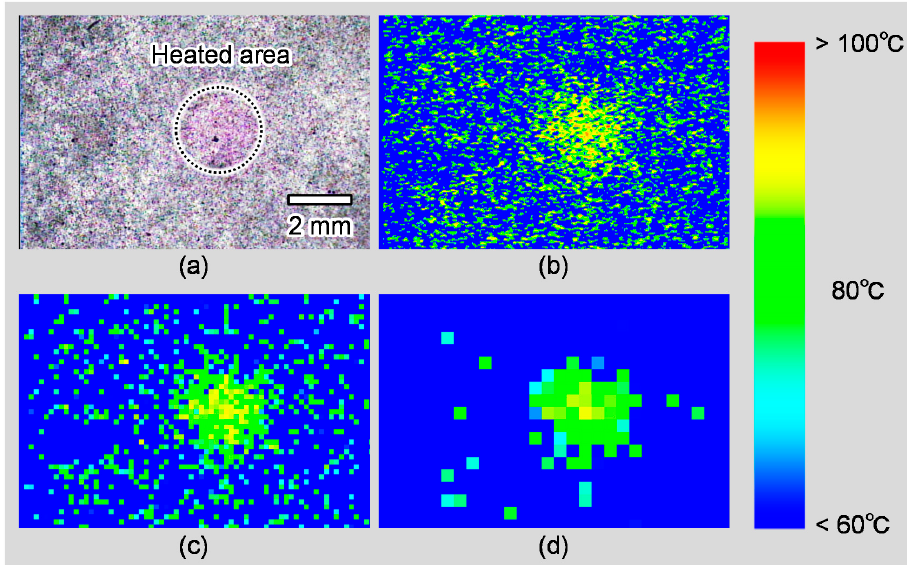
Figure 8. Evaluation of local heated temperature with different averaged areas. ( a ) Original picture of the sheet sample; ( b ) Analyzed image without averaging; ( c ) Analyzed image averaged with 10 × 10 pixels; ( d ) Analyzed image averaged with 25 × 25 pixels. Color bar shows the corresponding maximum heated temperature.